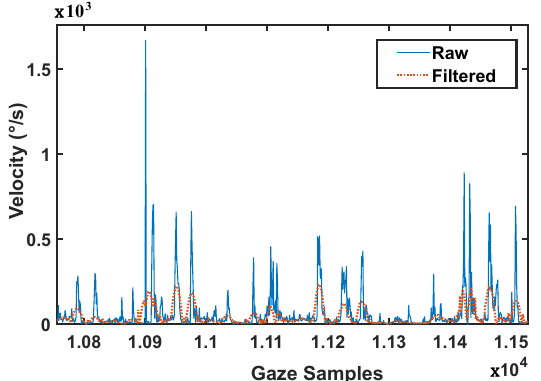
Figure 5. Gaze samples were filtered using the Savitzky–Golay filter, with second-order polynomials and 24 filter length. In the dataset, the effect (red) on simple, raw (blue), sample-to-sample